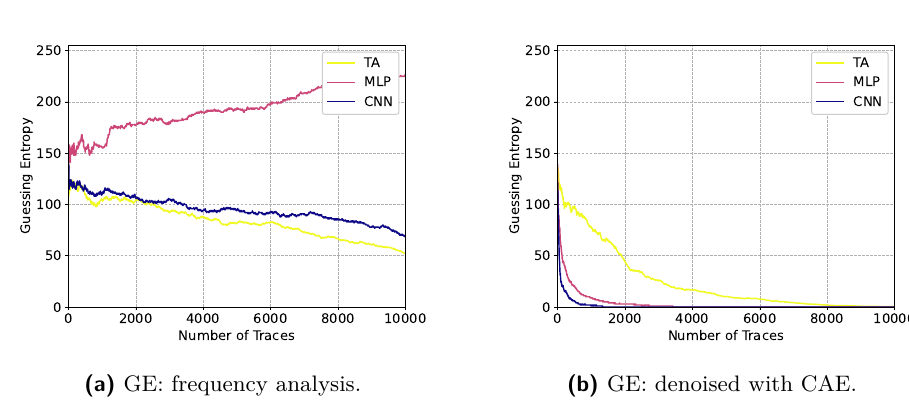
Figure 6: Guessing entropy: denoise Random Delay Interrupts with frequency analysis vs